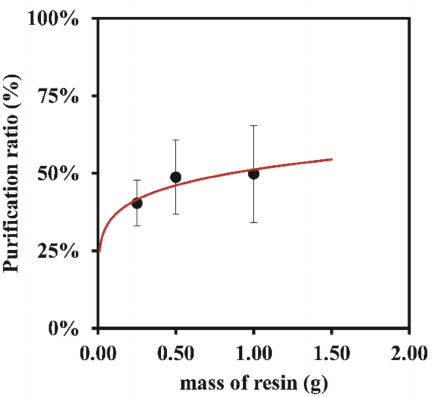
Figure 8. Variation in the purification ratio (%) at 15 min of adsorption time with the different masses of the resin Bio-Rad 50W-X8 200–400